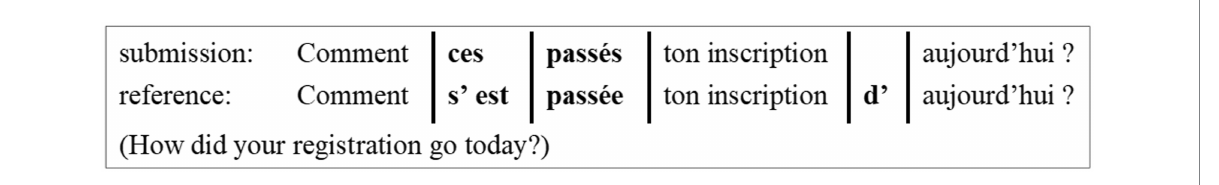
FIGURE 1 Illustration of error boundary detection (the black vertical lines indicate the boundaries of